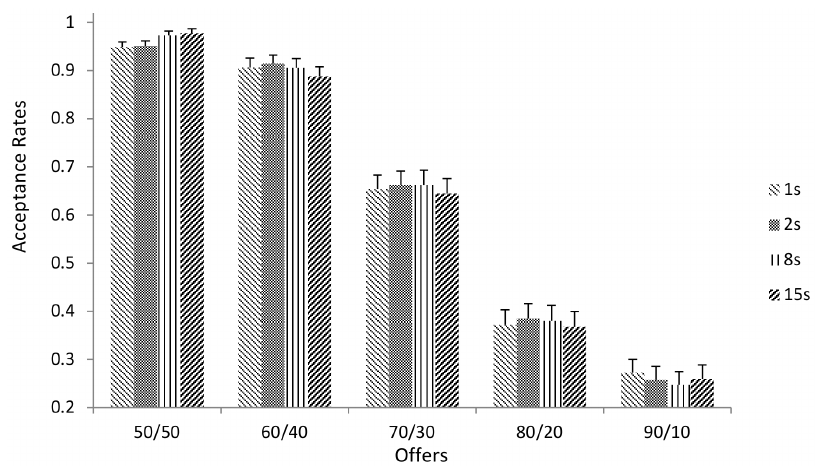
Figure 4. Average Acceptance rates for Different Time Delays for Each Offer. Error bars = standard error of the mean.